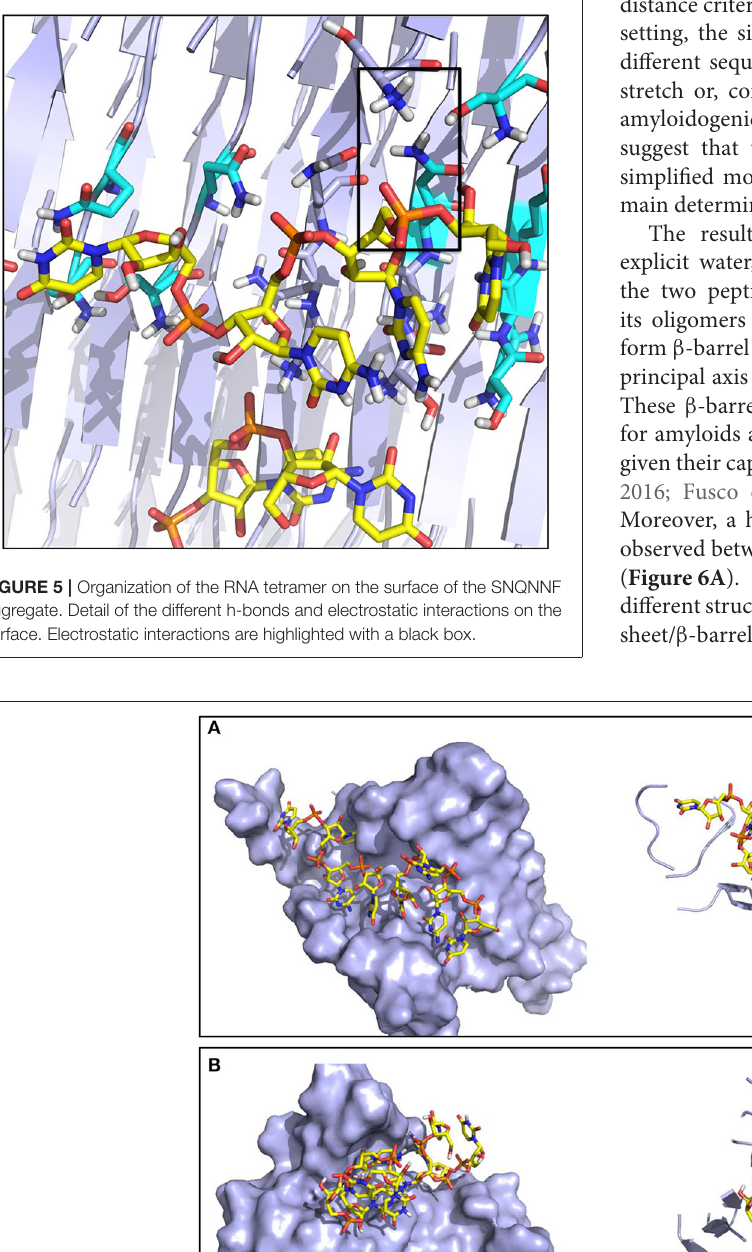
Frontiers in Molecular Biosciences |